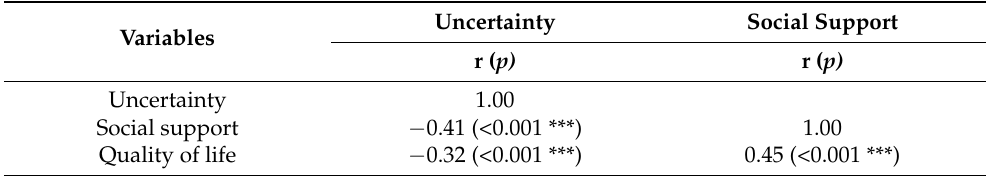
Table 2. Correlations between uncertainty, social support, and quality of life (n =